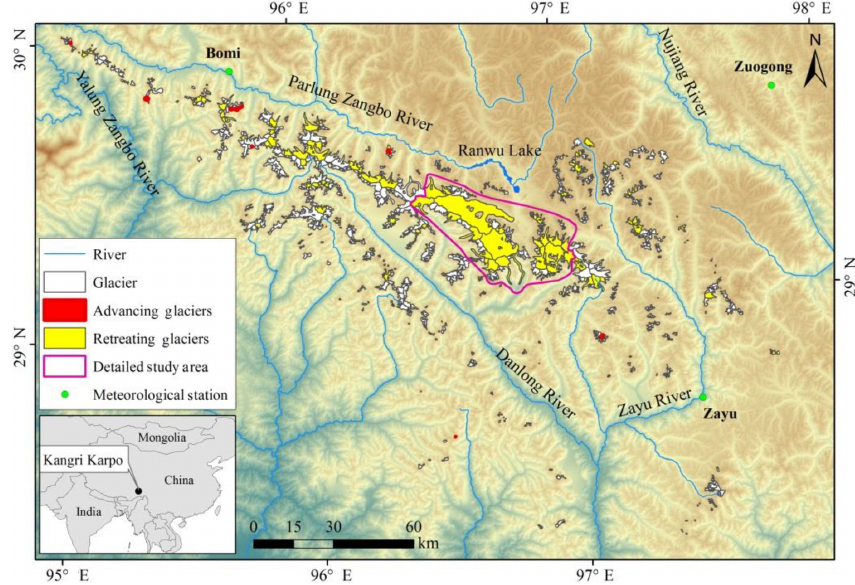
Figure 1. Study area and glacier distribution, including an outline of the detailed study area and meteorological stations. 96 glaciers were selected to generate centre lines and calculate length change, and then categorized as advancing glaciers or retreating